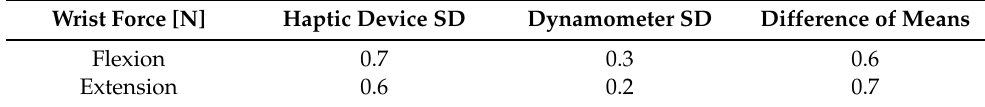
Table 4. Standard deviations (SD) and Difference of Means of force